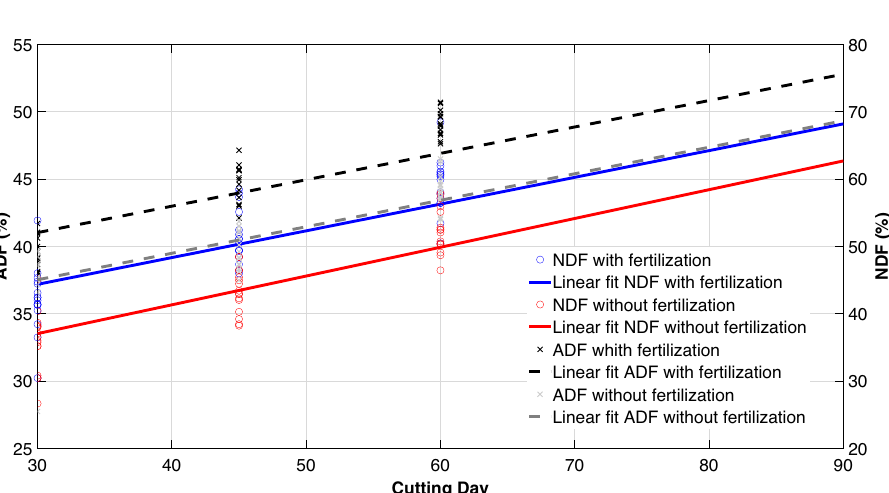
Figure 4. Linear relationship between neutral detergent fiber (NDF), acid detergent fiber (ADF) of King grass on different cutting days and in systems with and without fertilization. Plots were created in MATLAB R2021a. Lineal regression equations ( C cutting day): Neutral detergent fiber with fertilization = 0.3922C + 40.2785. r 2 = 0.8228, n = 63, P < 0.005. Neutral detergent fiber without fertilization = 0.3937C + 33.2255. r 2 = 0.8383, n = 63, P < 0.005. Acid detergent fiber with fertilization = 0.1986C + 31.2225. r 2 = 0.7877, n = 63, P < 0.001. Acid detergent fiber without fertilization = 0.2138C + 27.1088. r 2 = 0.8436, n = 63, P <